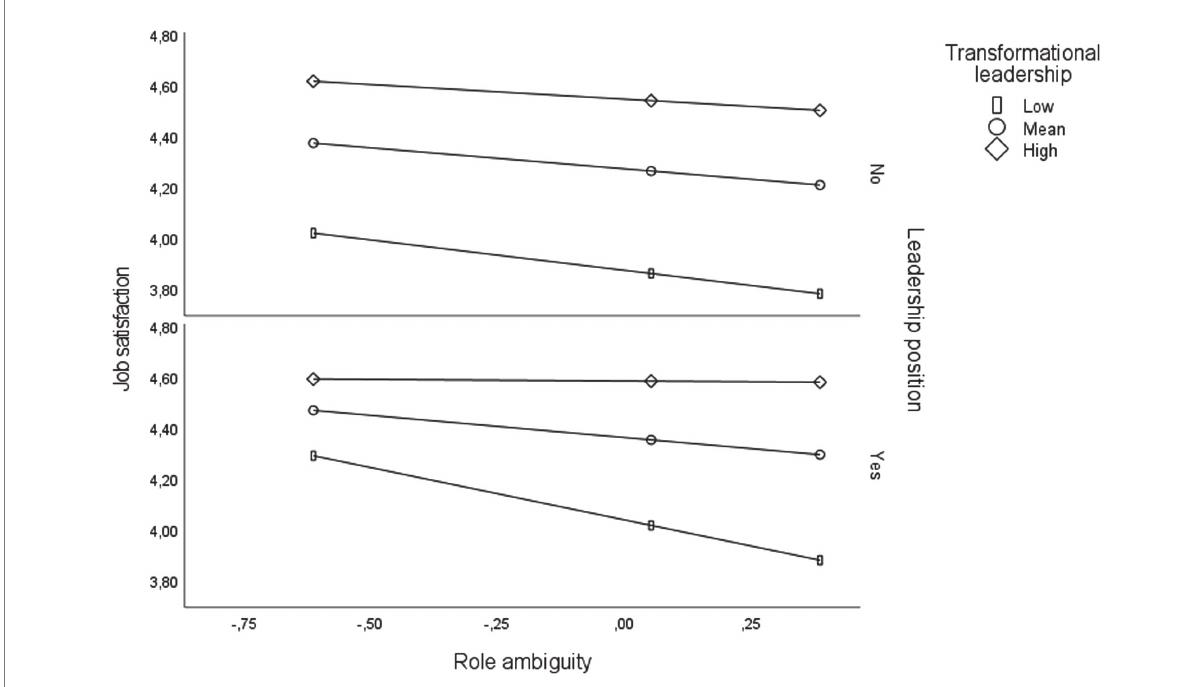
FIGURE 2 Three-way interaction between role ambiguity, transformational leadership, and position as a supervisor regarding job satisfaction adjusted for age, gender, and job tenure (Study